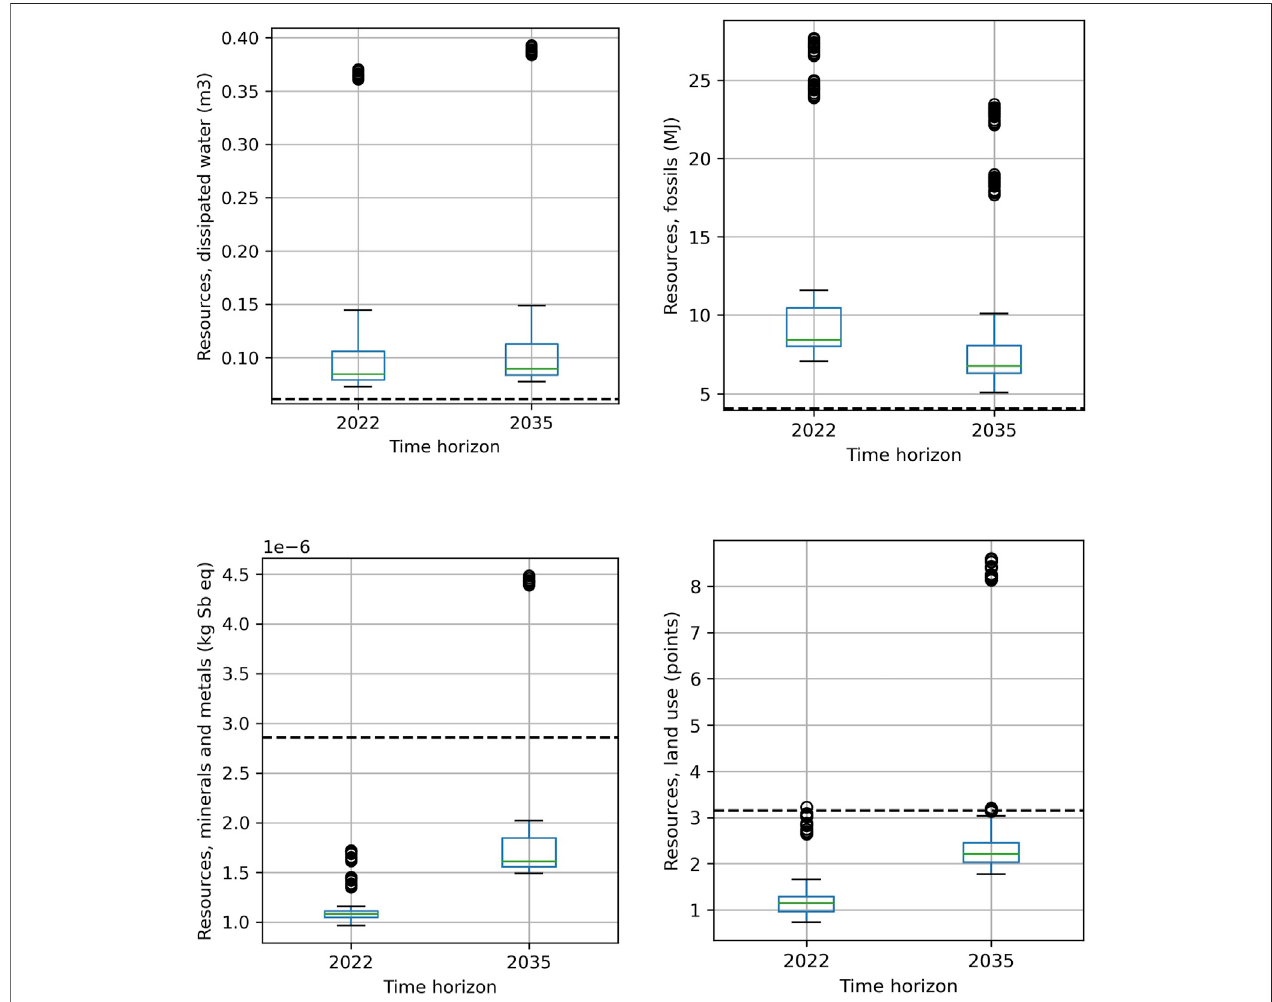
FIGURE 5 | Scenarios distribution for midpoint impacts on resources consumption with the two production time-horizons — the dashed line shows the impact of 1 kg of Portland cement.